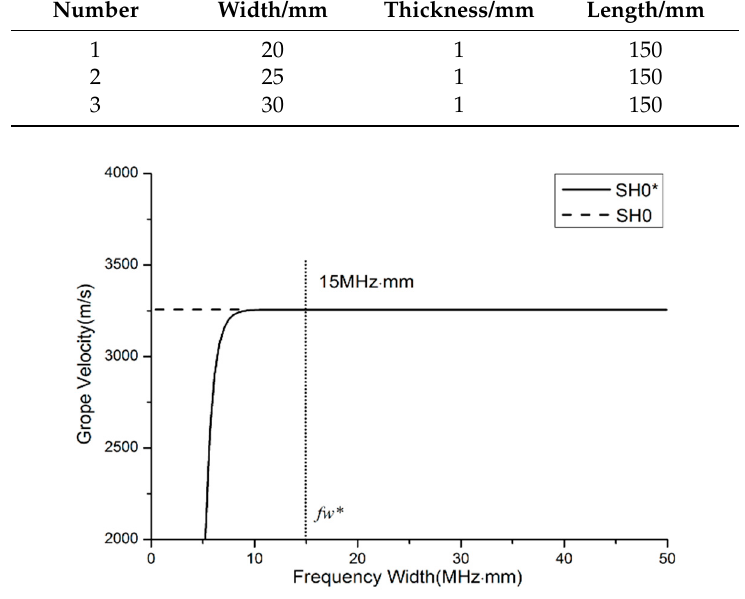
Figure 4. Simulated group velocity dispersion curves against the frequency-width product.